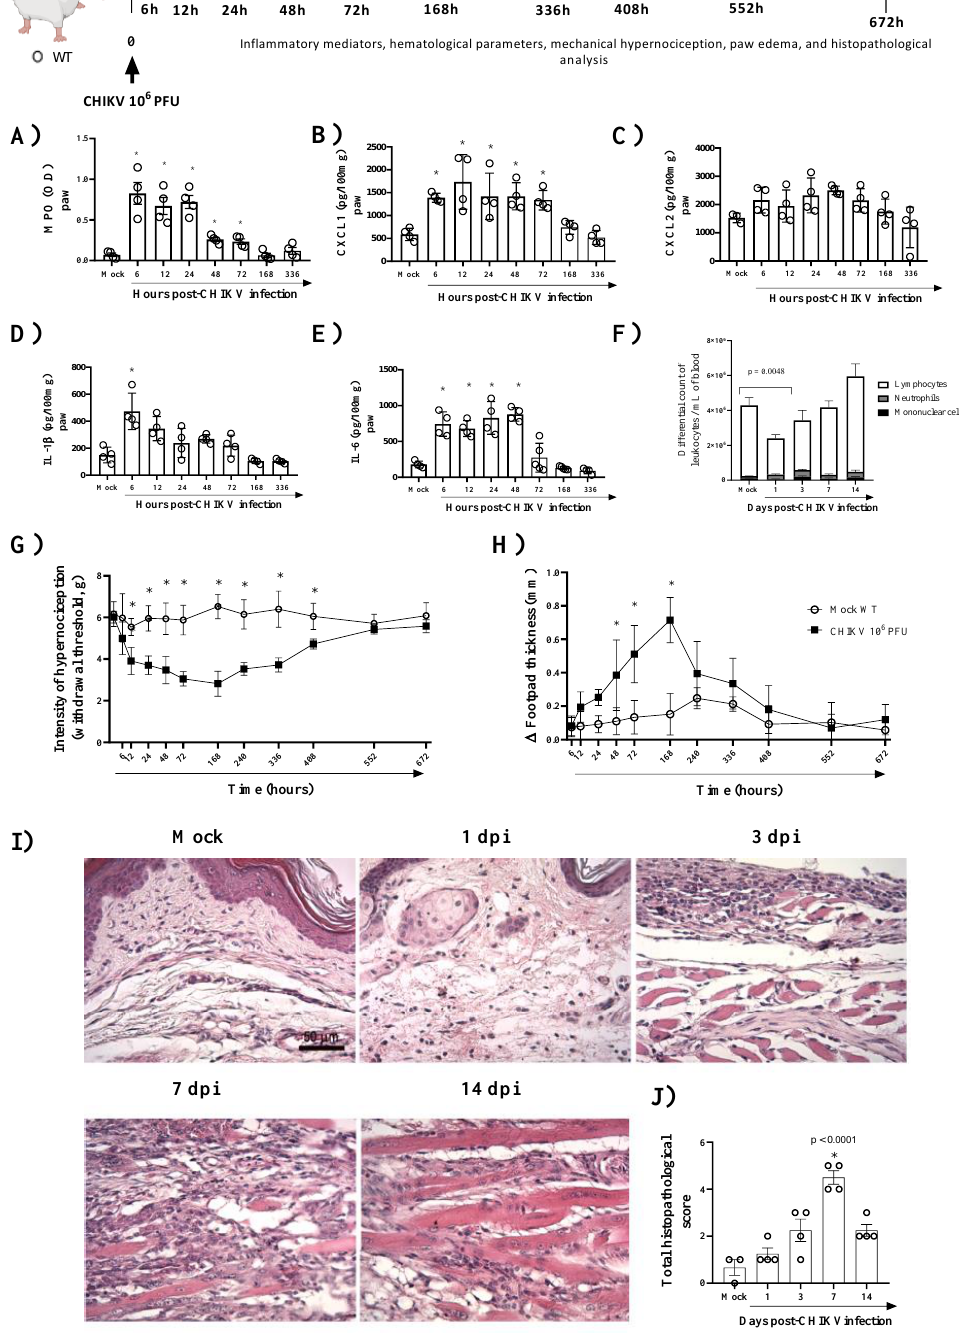
Figure 1. CHIKV-infected mice show inflammation, prolonged hypernociception, edema and tissue damage in the paw. Wild-type (WT/BALBc) mice were infected by the intraplantar (i.pl.) route with CHIKV 10 6 PFU and then were euthanized at 6, 12, 24 (1 dpi)-, 72 (3 dpi)-, 168 (7 dpi)- or 336 (14 dpi)-hours post-infection. ( A ) MPO, ( B ) CXCL1, ( C ) CXCL2, ( D ) IL- 1β, and ( E ) IL-6 levels in the footpad of mice. ( F ) Differential white blood cell count. The cytokines and chemokines levels were measured by ELISA and were shown as pg per 100 mg of the footpad. ( G ) Mechanical hyperno- ciception and ( H ) Paw swelling of mock ( n = 5) and WT + CHIKV ( n = 5) groups. Data for mechanical hypernociception are shown as the force (g) required to induce dorsiflexion of the tibiotarsal joint, followed by paw withdrawal. The results for paw edema are expressed by Δ of the difference be- tween the baseline and post-infection measurements, expressed in mm. Statistical analysis was per- formed using a two-way ANOVA with Sidak comparisons tests. Data are presented as mean ± SEM ( n = 5 – 6 per group); * p < 0.05 when compared to control uninfected mice (mock). ( I ) Representative H&E images (magnification 400×, scale 50 µm) of inflamed joint footpad at 1, 3, 7 or 14 days post- infection. ( J ) Histopathological scoring ( n = 3 – 4). Statistical analysis was performed using Kruskal – Wallis with Dunn ’ s multiple comparisons. * for p < 0.05 when compared with the WT infected group.